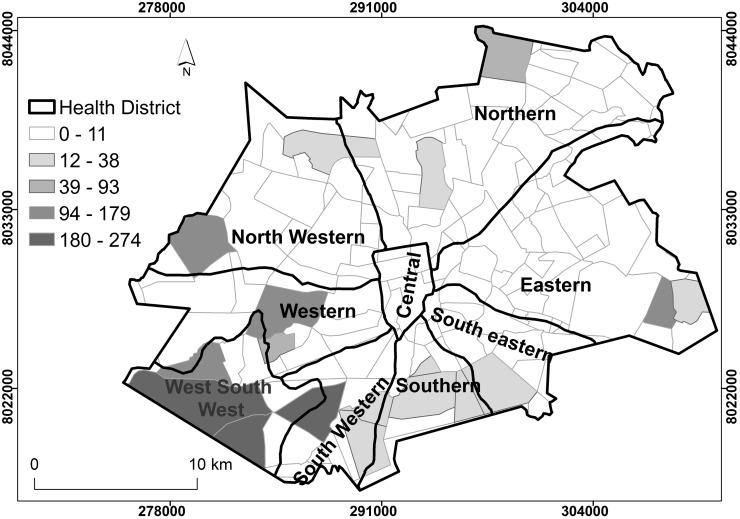
Spatial distribution of TB prevalence rates by district, Harare City, 2012.Show the spatial distribution of TB prevalence rates by district. Clear suburbs and districts show that TB cases were not related to neighbouring districts. Shaded districts showed relatedness. The intensity of the shade reflected the number of TB cases per district related to neighbouring districts.